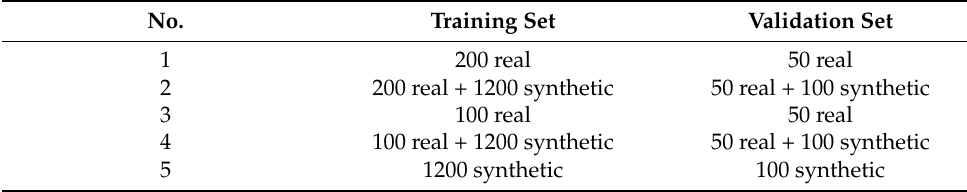
Table 3. The composition of the five datasets.